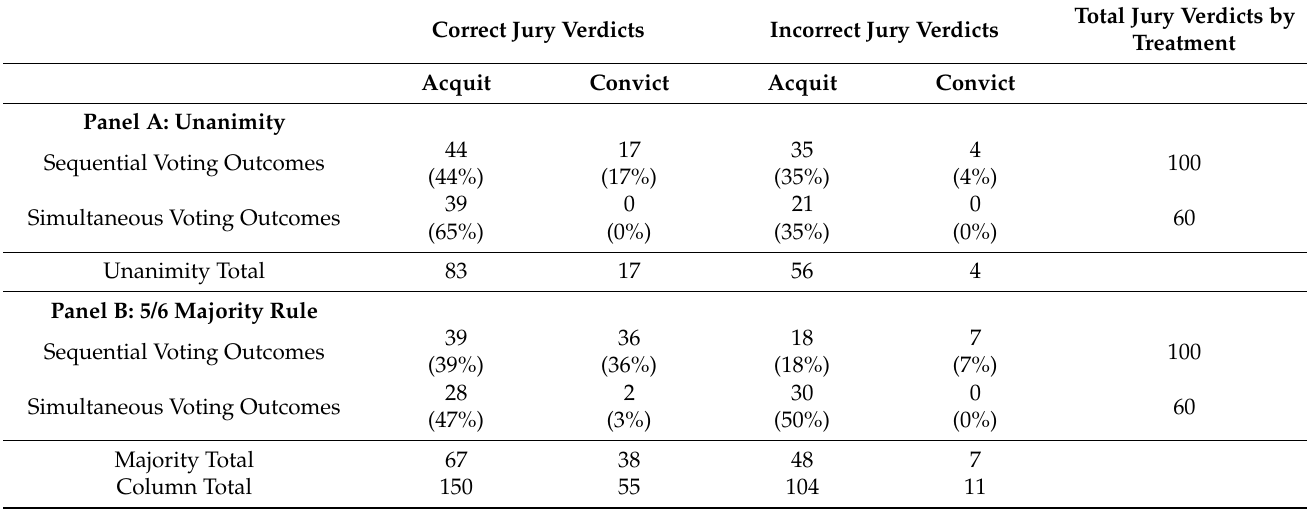
Table 6. Summary of all jury